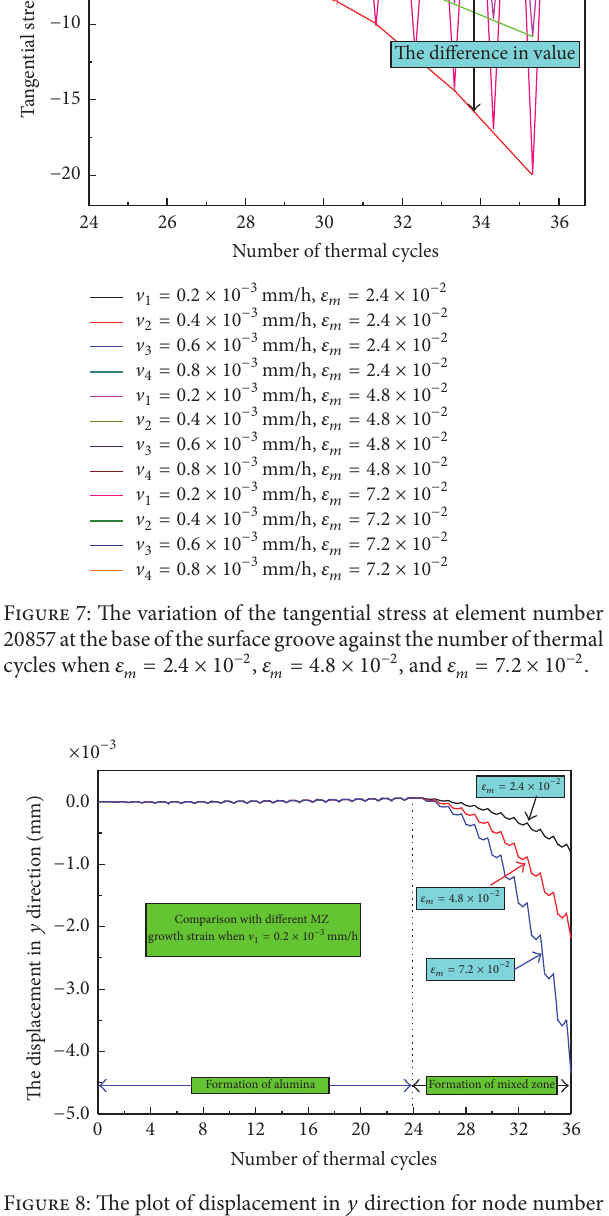
Figure 8: The plot of displacement in 𝑦 direction for node number 517 at the base of the surface groove against the number of thermal cycles when V 1 = 0.2 × 10 −3 mm/h.